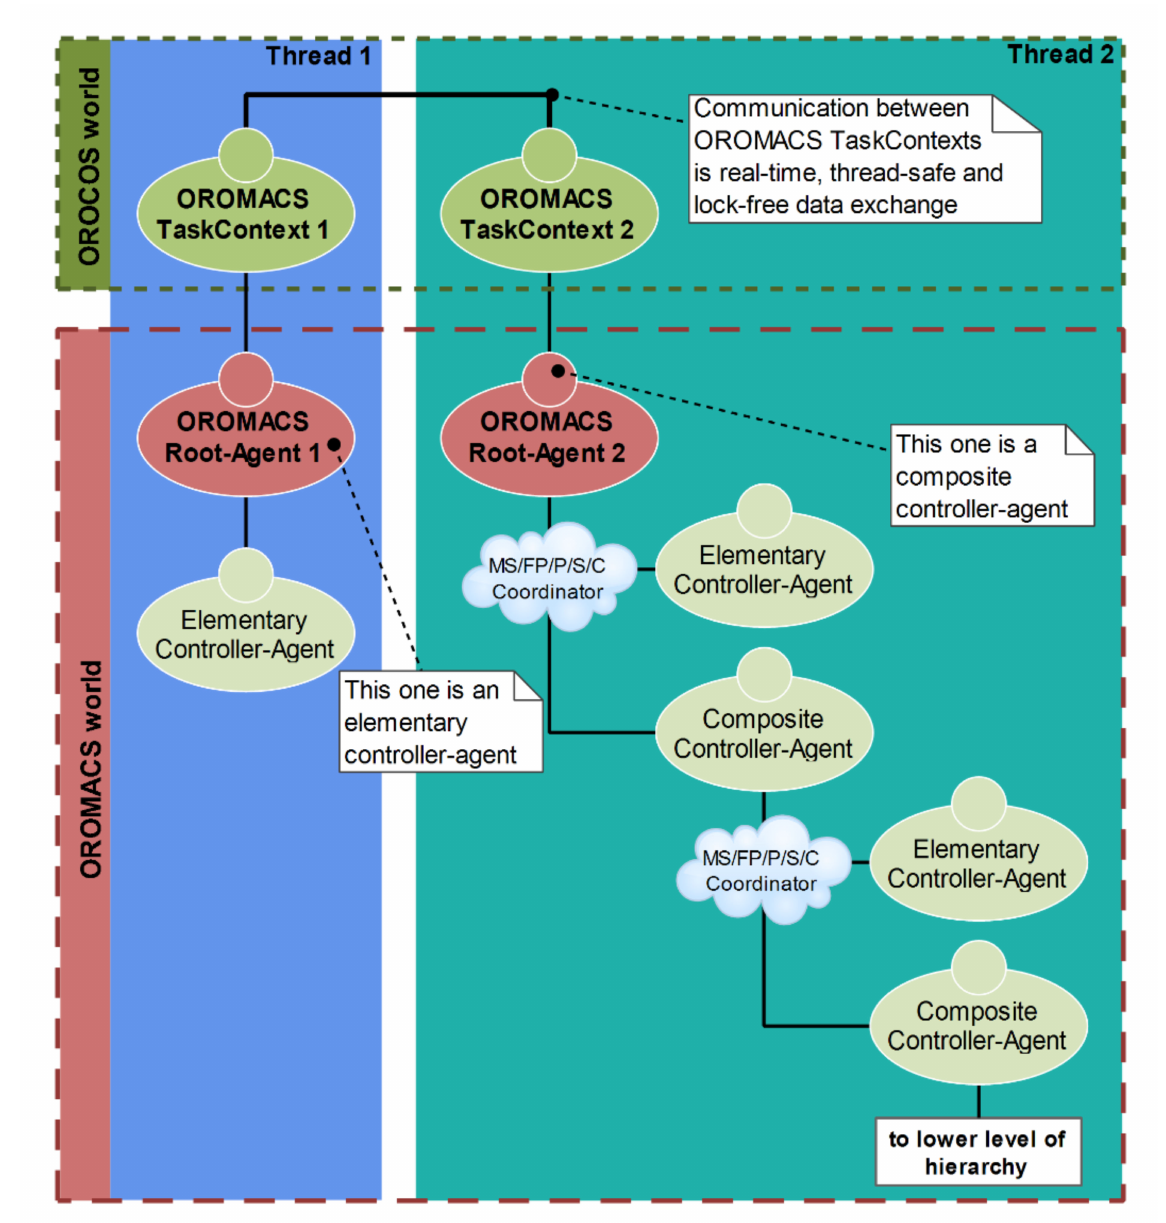
Figure 2. Hierarchically structured multiagent control system (MACS) using the controller-agent-based design frame- work